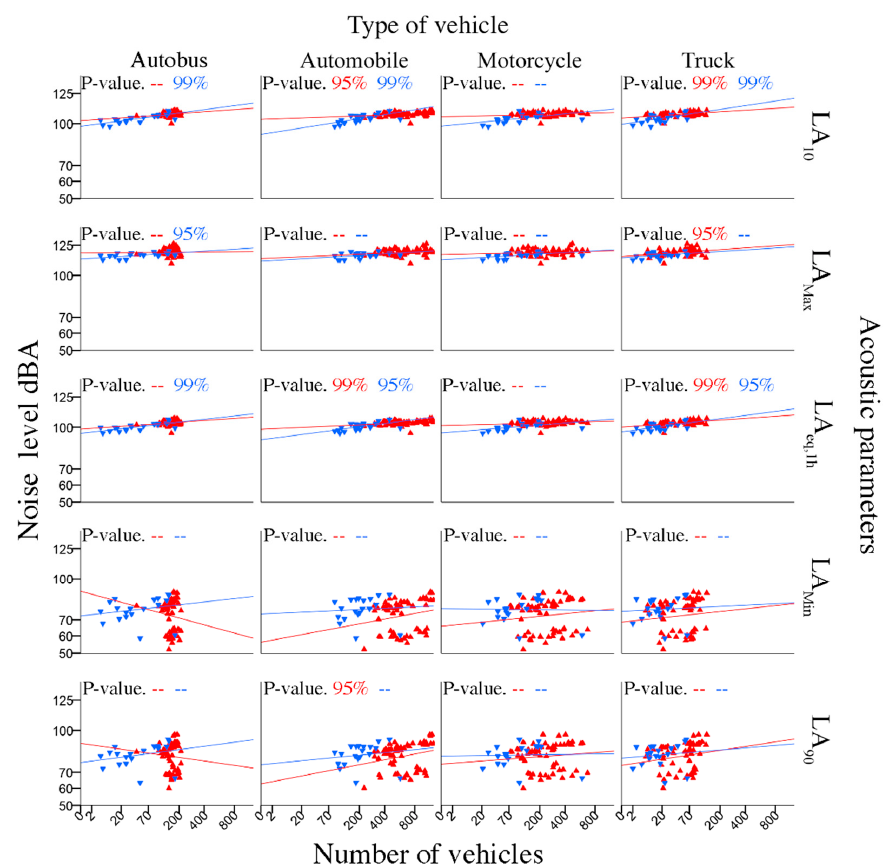
Figure 7. Pearson correlation coefficient between acoustic parameters and vehicle type (Sig.: signif- icance grade, ▲ : day, and ▼ : night).